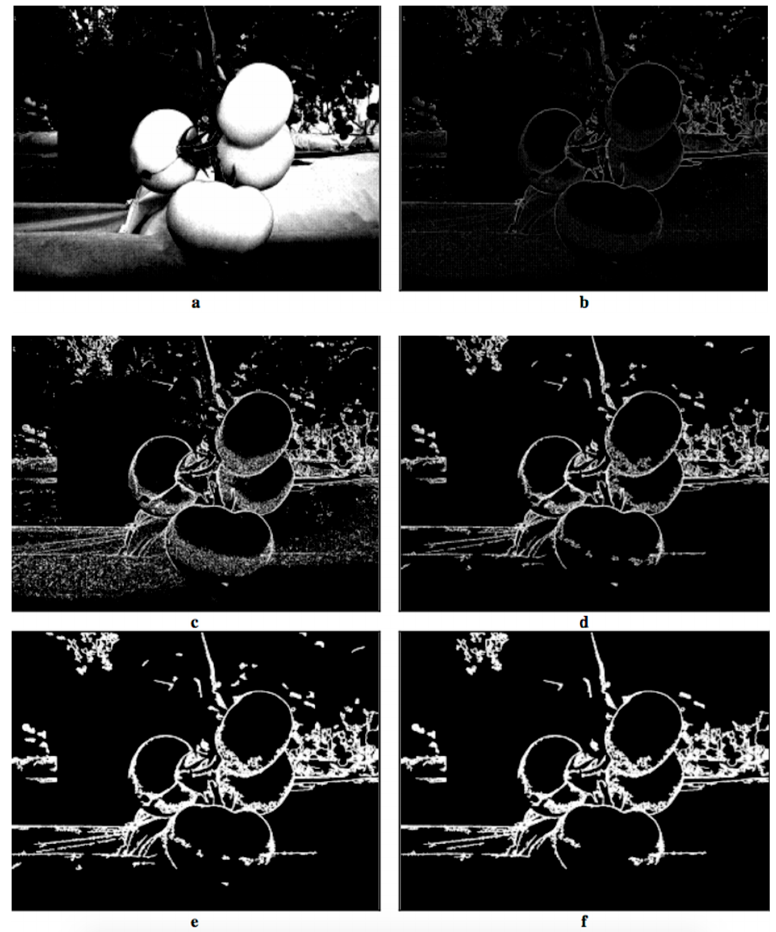
Figure 7. ( a ) Power transform and contrast enhancement; ( b ) Sobel operator; ( c ) gray-scale segmentation; ( d ) size segmentation; ( e ) dilation; and ( f ) size segmentation